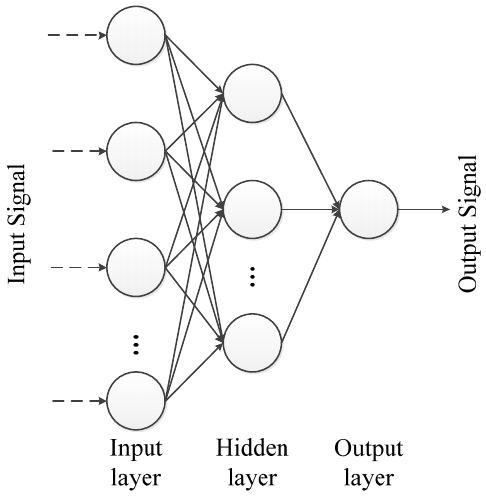
Figure 6. A three ‐ layers artificial neural network.